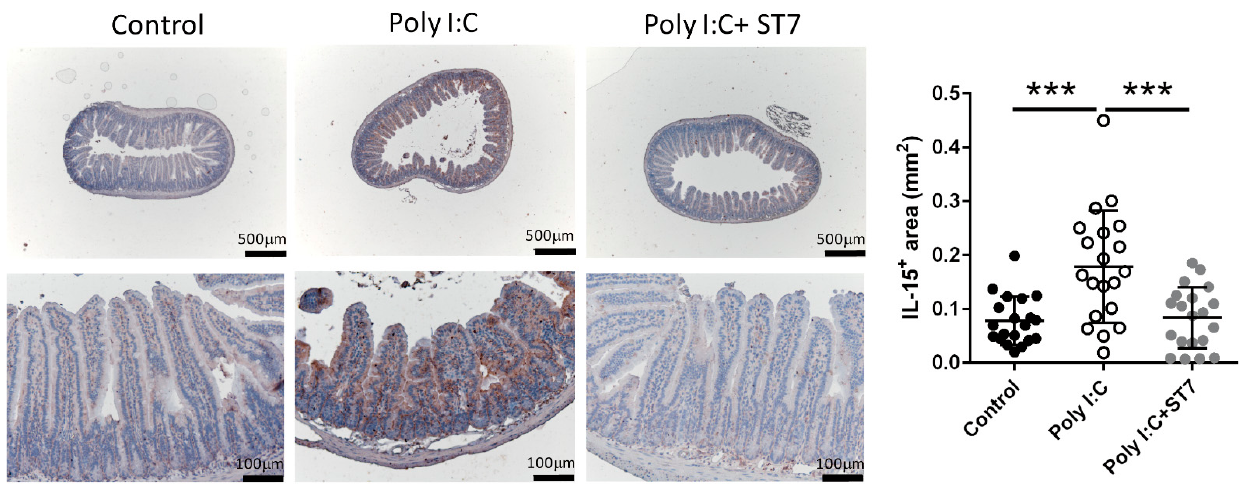
Figure 3. ST7 treatment prevents the upregulation of IL-15 in the intestinal villi after poly I:C stimulation. The expression of IL-15 in the intestinal villi was detected using immunohistochemistry. n = 5 per group. The graph depicts the quantification of the IL-15 + area in the small intestine. Four coronal sections were obtained from each mouse. Each dot indicates the IL-15 + area in each coronal section from the small intestines of mice. *** p < 0.001 .